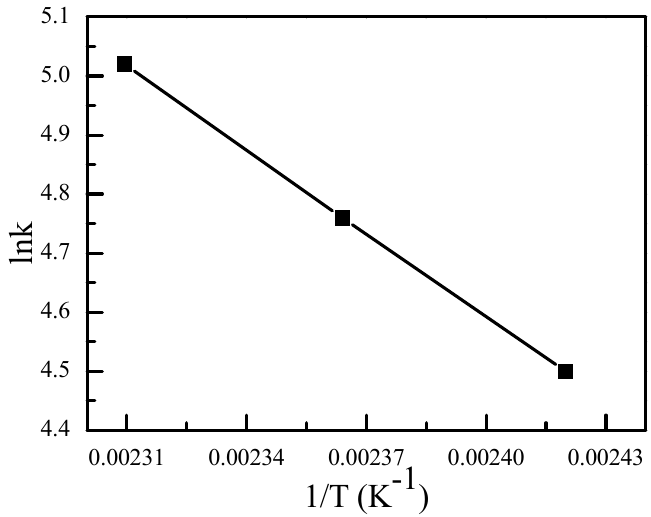
Figure 7. Arrhenius plot for glucose dehydration in isopropanol over [HO 2 CMMIm]Cl–ZrOCl 2.